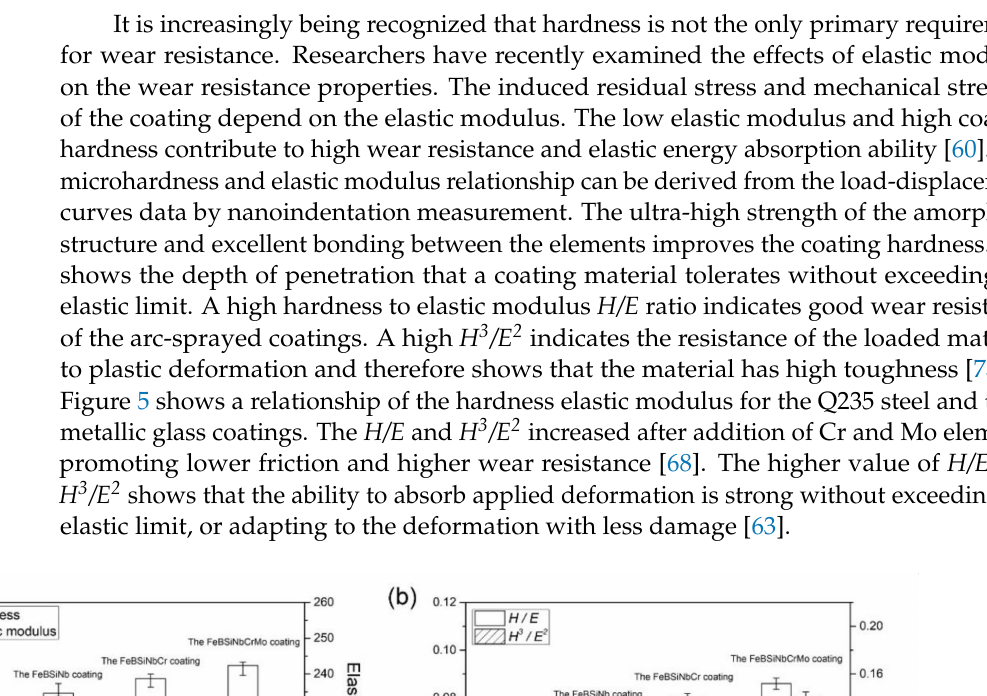
Figure 4. Wear losses of coating and substrate as a function of sliding distance. Reprinted with permission from ref. [74]. Copyright 2013 Elsevier.